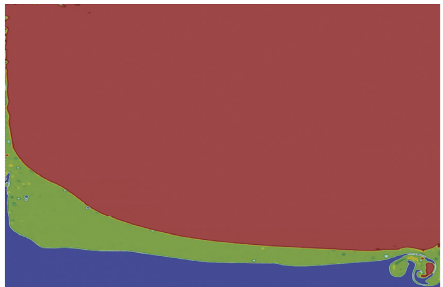
Figure 11: Interfacial mixing ( t �